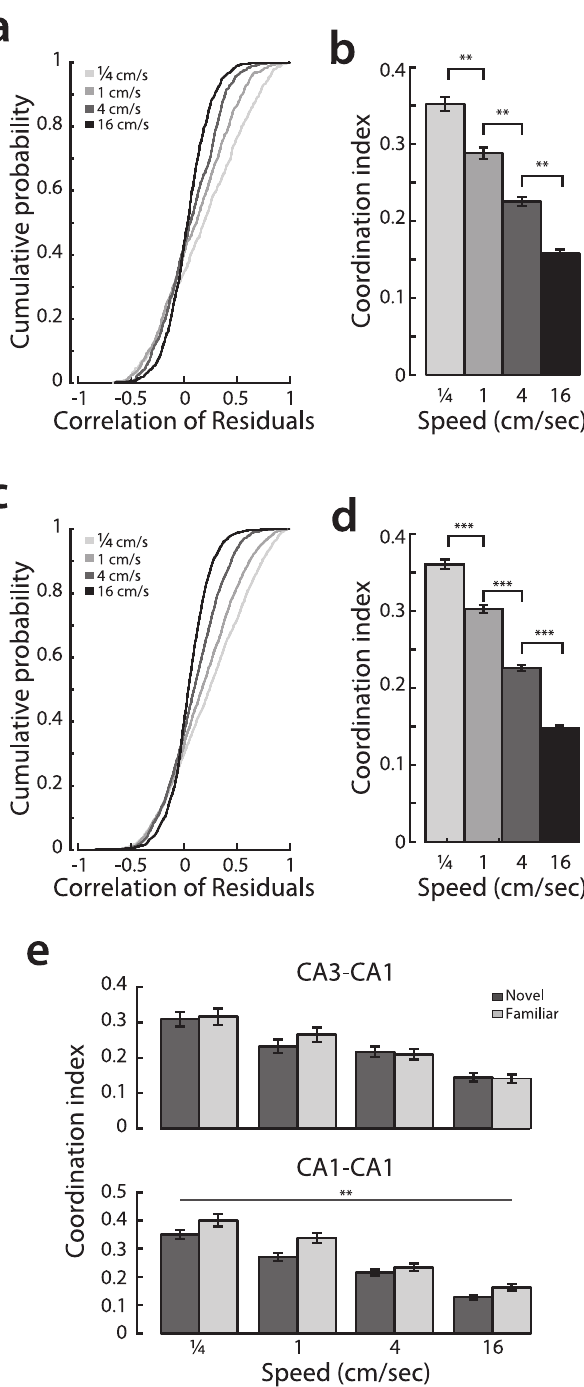
Figure 8. Correlated activity of CA3 and CA1 place cells is modulated by movement speed. a, Cumulative distribution of residual correlation of CA3-CA1 cell pairs across speed bins. b, Coordination index for CA3-CA1 cell pairs across speeds. c, Cumulative distribution of residual correlation of CA1-CA1 cell pairs across speed bins. d, Coordination index for CA1-CA1 cell pairs across speeds. e, ( top ) The coordination index between CA3 and CA1 place cells is strongly modulated by speed in both familiar (light gray) and novel (dark gray) epochs. However, ANOVA reveals no significant difference between speed modulation in familiar and novel environments. ( bottom ) In contrast, the coordination index of pairs of CA1